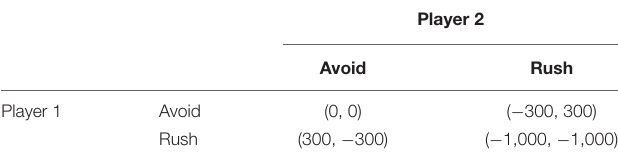
Player 2 Avoid Rush